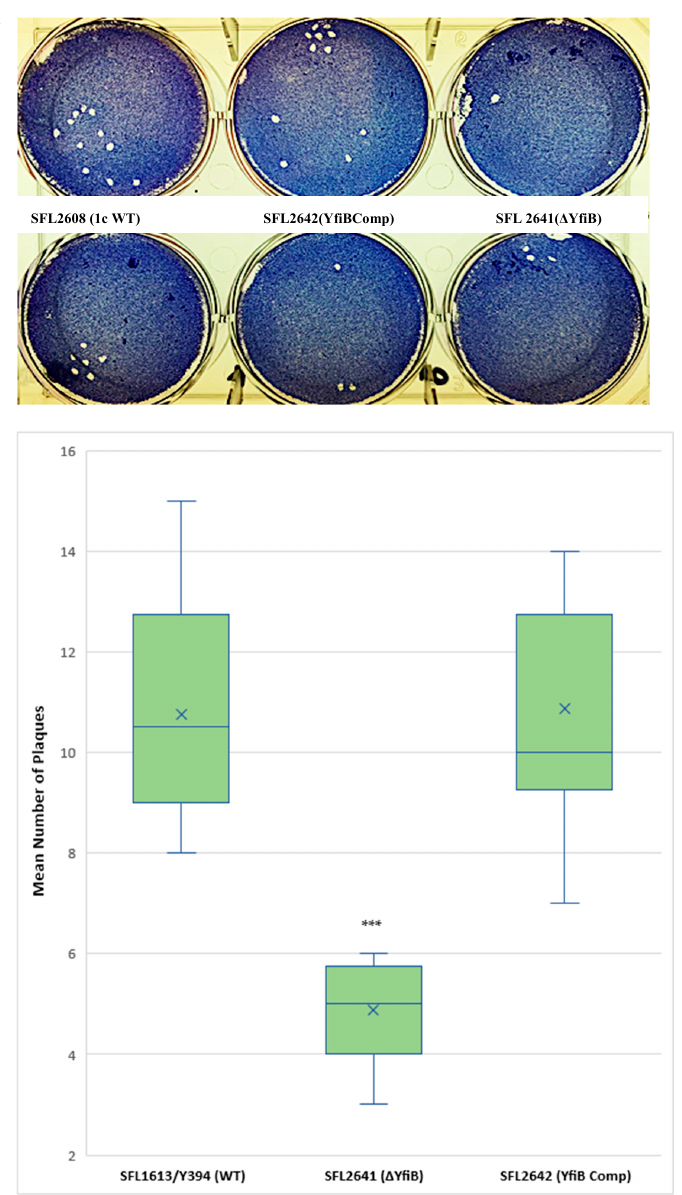
Figure 6. Plaque formation in HeLa cells by S. flexneri strains. ( A ) Visual assessment of the plaques formed on the cellular monolayer at 72 h post infection, with clear plaques representing dead cells